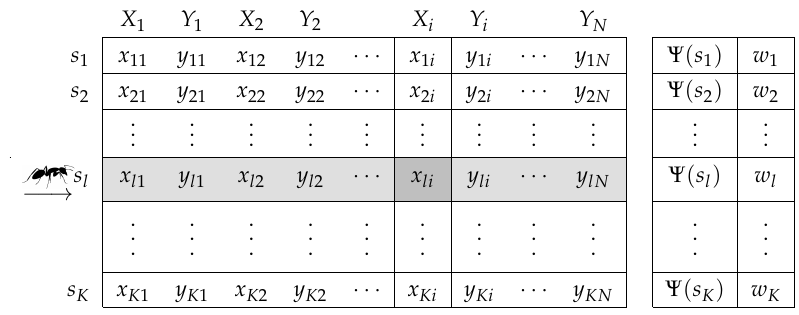
Figure 4. Solution archive ( T ) used by ACO R in the placement optimization problem.